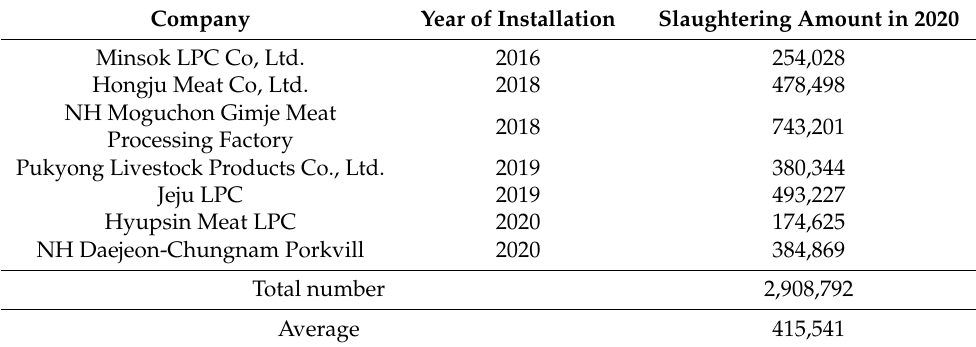
Table 3. List of slaughterhouses installed ‘VCS2000’ and their slaughtering amount in 2020. Company Year of Installation Minsok LPC Co,